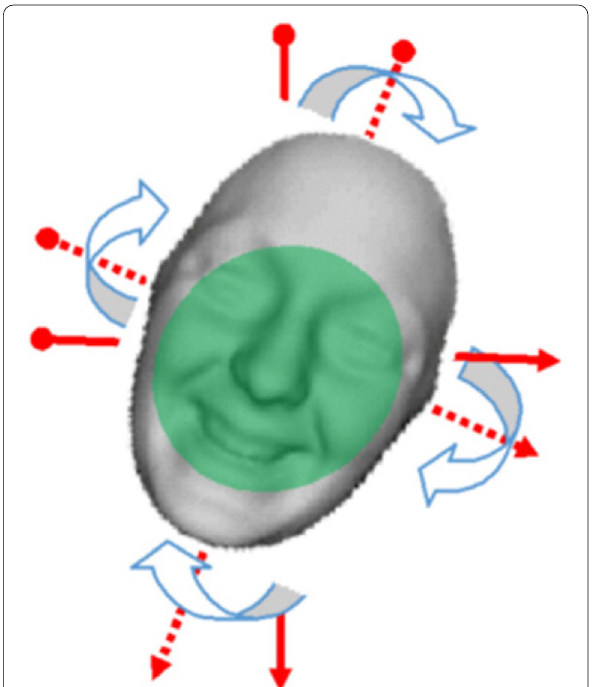
Fig. 2 Tracking of 3D feature points from one frame to